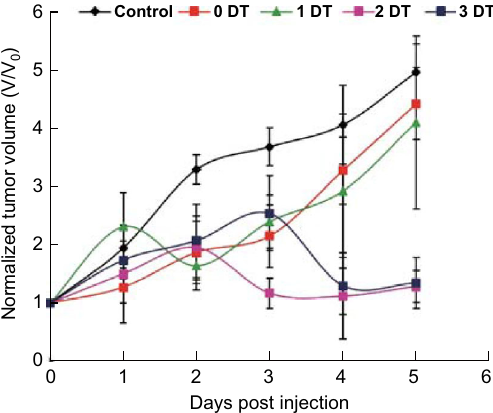
Fig. 5 Changes in normalized tumor volume of larvae subjected to different days of light illumination; 0 dpi depicts 7 dpf larvae immediately after intravenous injection. 0-Day therapy (0 DT) refers to WL illumination on 0 dpi. n =